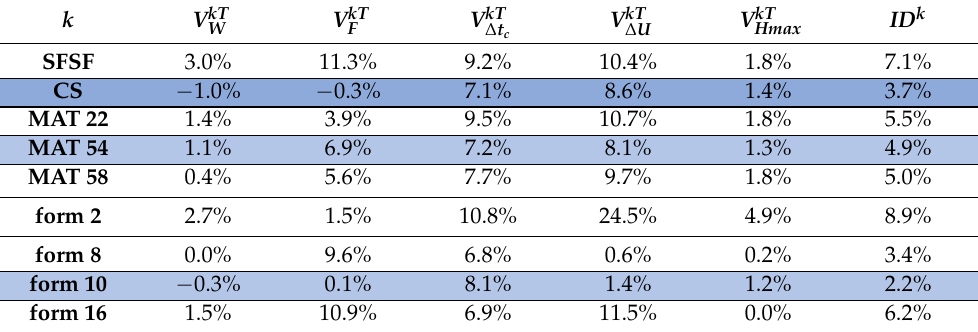
Table 7. Indices for the choice of the numerical setup. Comparison with the